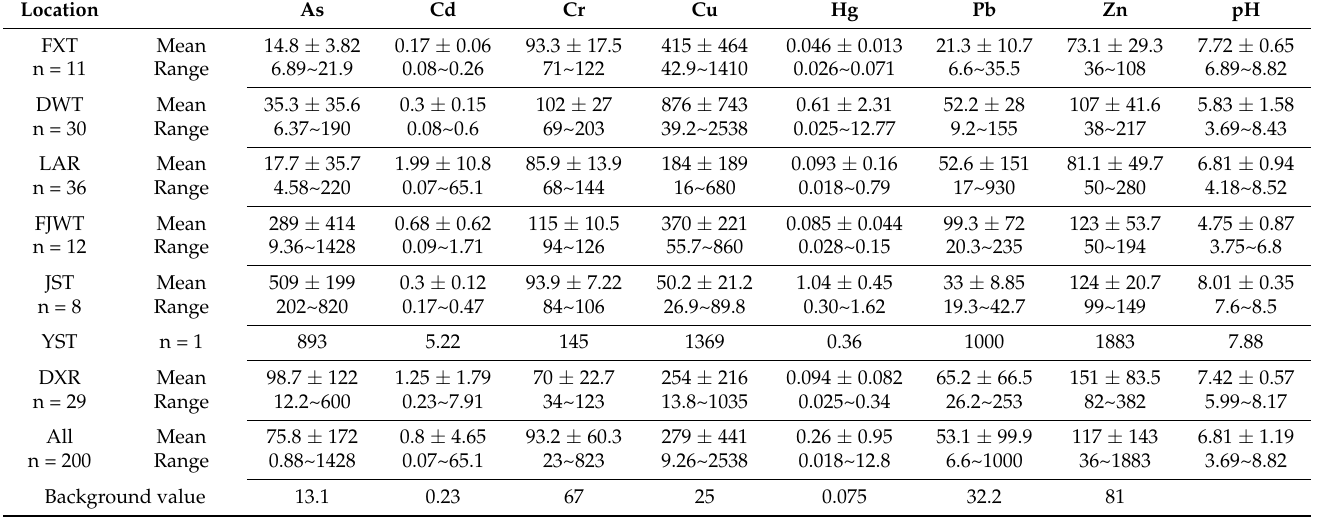
Table 3. Summary of the background values and basic statistics of HMs and pH in the sediment